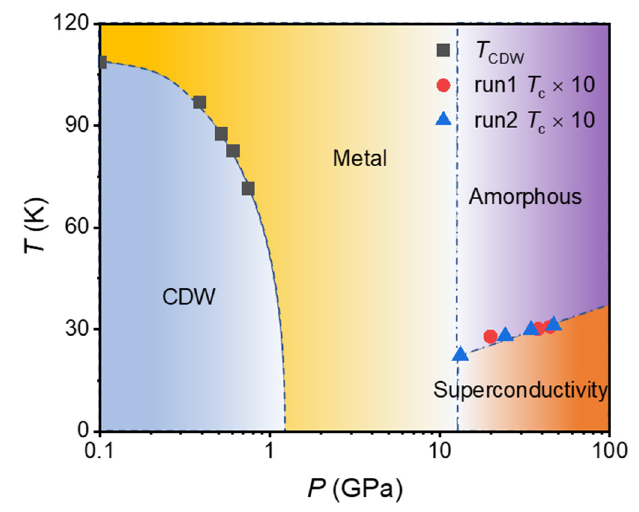
Figure 5. Phase diagram of PdTeI. The T CDW and T c determined from the resistivity measurements are shown as a function of pressure.